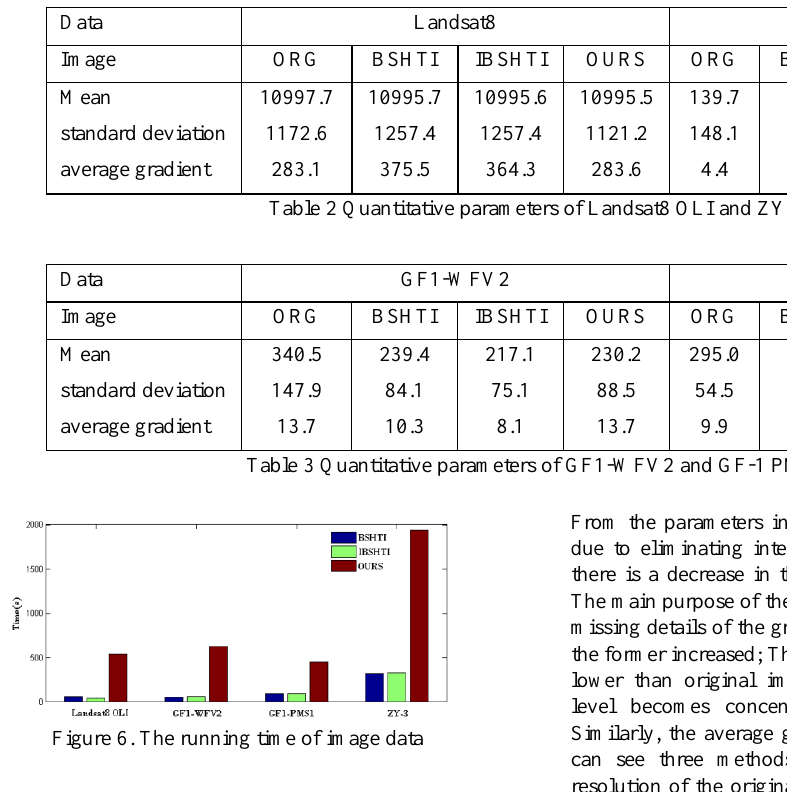
Figure 5. Correction results of ZY-3 among BSHTI,IBSHTI and OURS